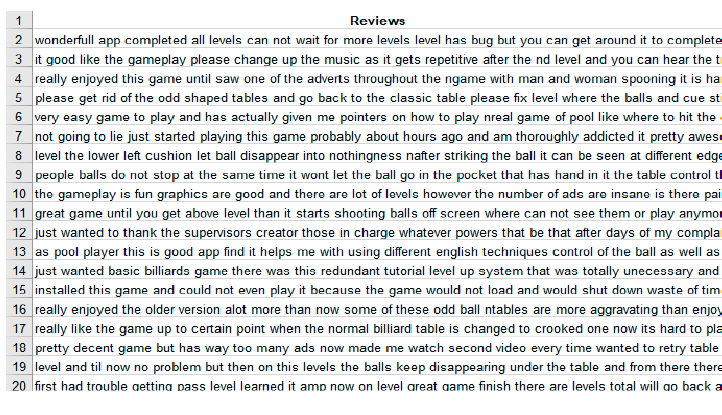
Figure 14. Sample screenshot of the cleaning dataset after preprocessing.